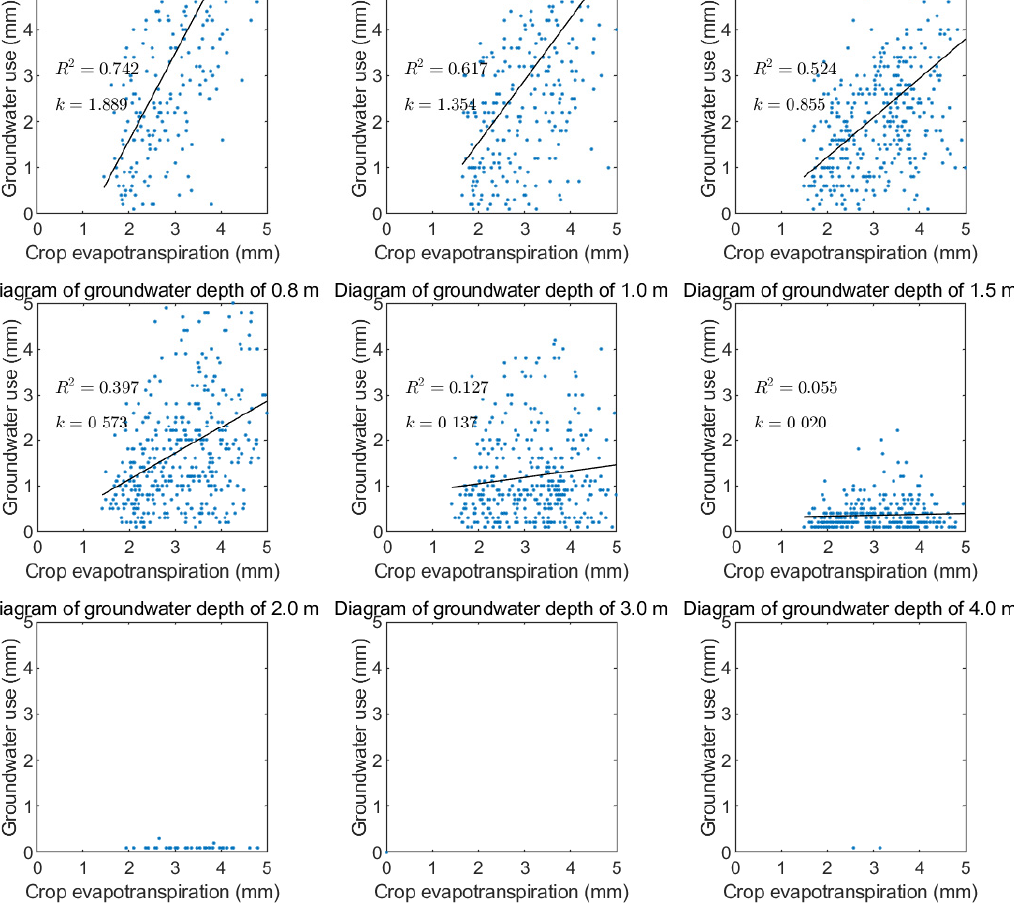
Figure 4. Scatter diagrams of soybean evapotranspiration and groundwater contribution for various groundwater depths in the flowering–podding stage.